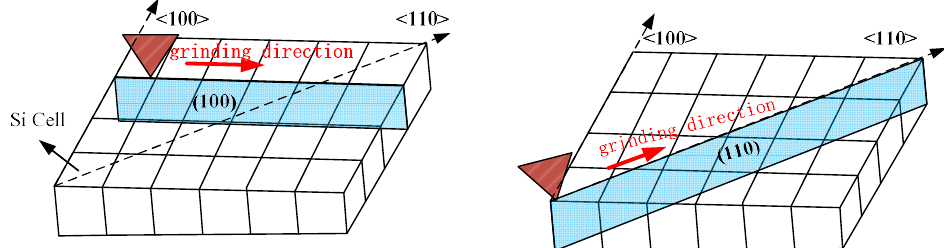
Figure 9. Schematic diagram of grinding direction and crystal orientation.